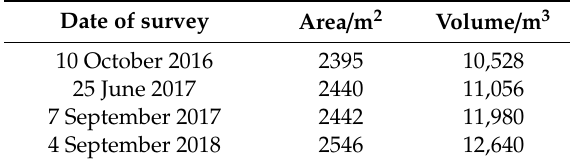
Table 1. Morphometric characteristics of the model section of the Bulanka gully.